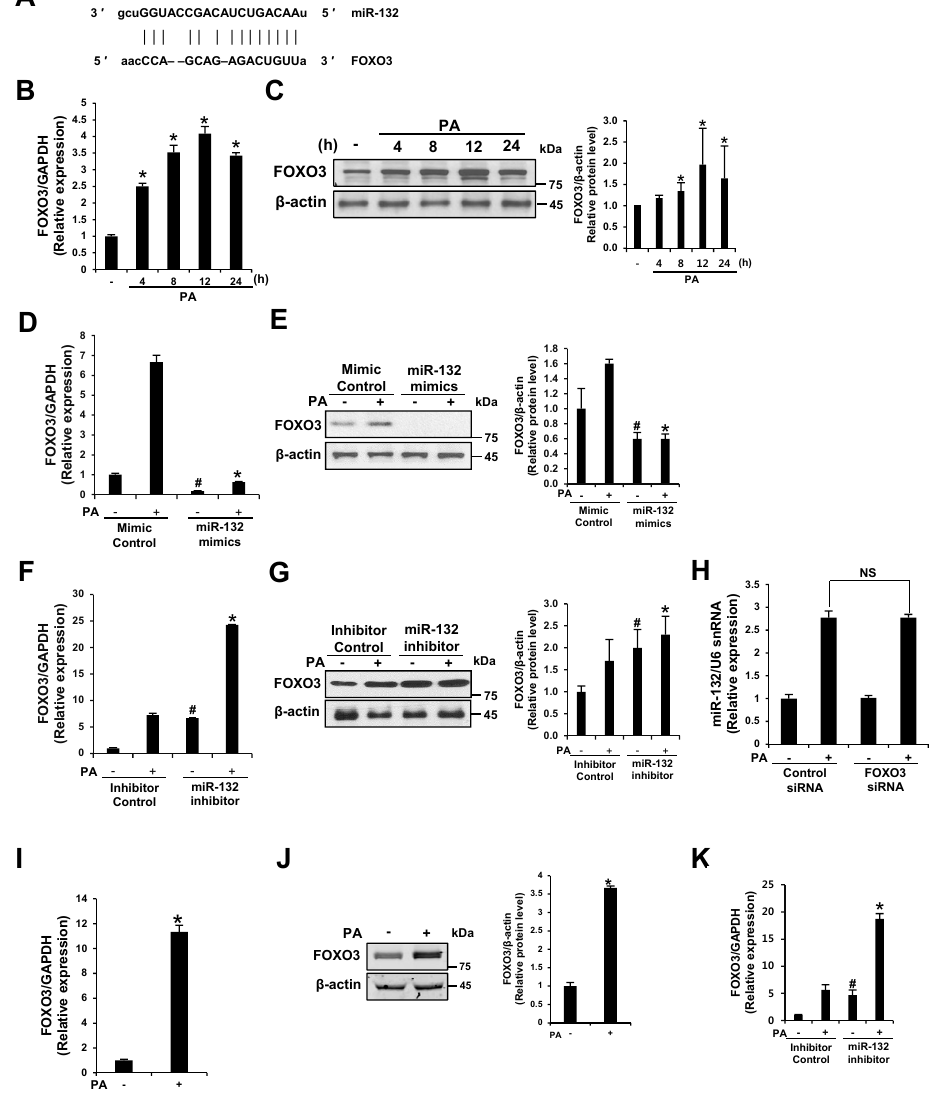
Figure 5. FOXO3 is a target of miR-132. ( A ) miR-132 targets were predicted using TargetScan (www.targetscan.org) and microRNA (www.microrna.org); ( B ) PA induces the mRNA expression of FOXO3; ( C ) PA induces the protein expression of FOXO3; ( D – G ) THP-1 cells were transfected with a mimic negative control, mimic, inhibitor negative control, or inhibitor of miR-132 at 20 nM for 48 h before treatment with 200 µ M PA for 12 h; ( D , F ) The effect of the miR-132 mimic and inhibitor on the FOXO3 mRNA content was determined by quantitative RT-PCR; ( E , G ) Cell lysates were subjected to Western blot analysis using antibodies specific for FOXO3 and β -actin. β -Actin was used as a loading control; ( H ) The effect of FOXO3 silencing on miR-132 expression was determined by quantitative RT-PCR in THP-1 cells. NS, no significance; ( I , J ) Primary murine macrophages were treated with 200 µ M PA for 12 h. Levels of FOXO3 mRNA and protein expression were measured; ( K ) Primary murine macrophages were transfected with inhibitor negative control or inhibitor of miR-132 at 20 nM for 48 h before being treated with 200 µ M PA for 12 h. FOXO3 mRNA was examined by quantitative RT-PCR. # p < 0.05 compared with the mimic or inhibitor negative control in PA-untreated cells, and * p < 0.05 compared with the mimic or inhibitor negative control in PA-treated